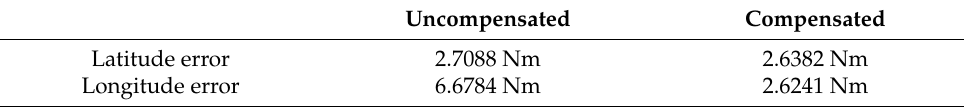
Figure 3. Position error according to the gyro bias error: ( a ) latitude error; ( b ) longitude error. Table 4. The results of the navigation simulation.